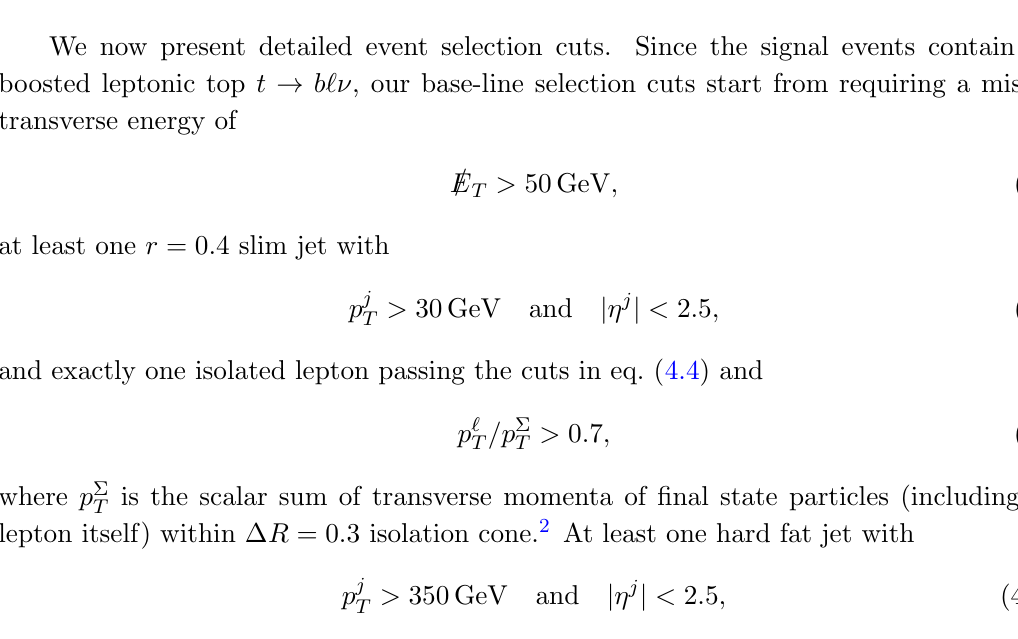
Table 1 . The summary of the SM backgrounds relevant to the ttgg channel and their cross sections after generation level cuts in eqs. (4.3){(4.5). Matching refers to either the 4-(cid:13)avor or 5-(cid:13)avor MLM matching [65]. The last column (cid:27) (cid:1) BR denotes the production cross section (in fb) times branching ratios including the top, W , and Z